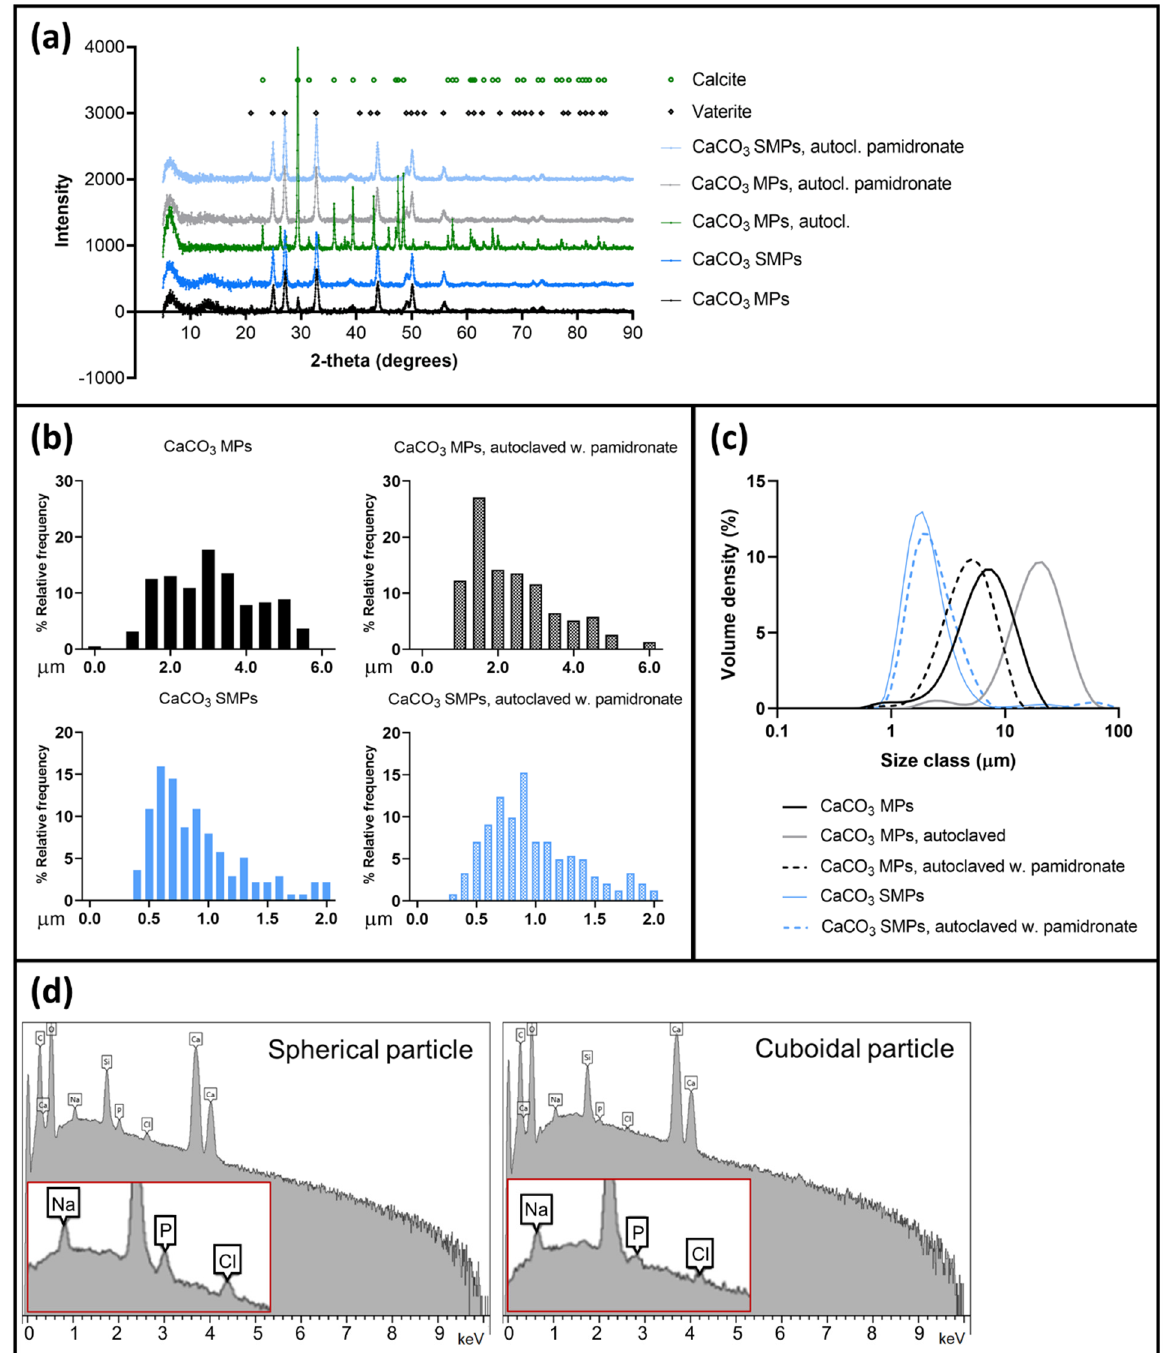
Figure 4. Physicochemical properties of various CaCO 3 particles. ( a ) X-ray diffraction spectra of various CaCO 3 particles. ( b ) Particle size distributions based on the circular or circle-equivalent diameters obtained from SEM images. ( c ) Particle size distributions based on laser diffraction. ( d ) Examples of EDX spectra of spherical and cuboidal particles from a sample of autoclaved CaCO 3 MPs with pamidronate. The Si peak originated from the silicon substrate on which the sample was placed.